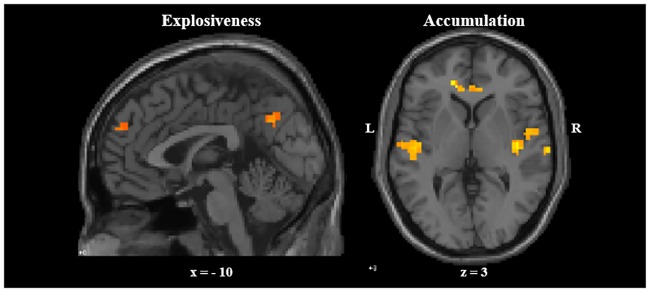
Neural correlates of emotion explosiveness and accumulation.Left panel: mPFC activation associated with emotion explosiveness. Right panel: Insula activation associated with emotion accumulation. Coordinates in the Talairach space.